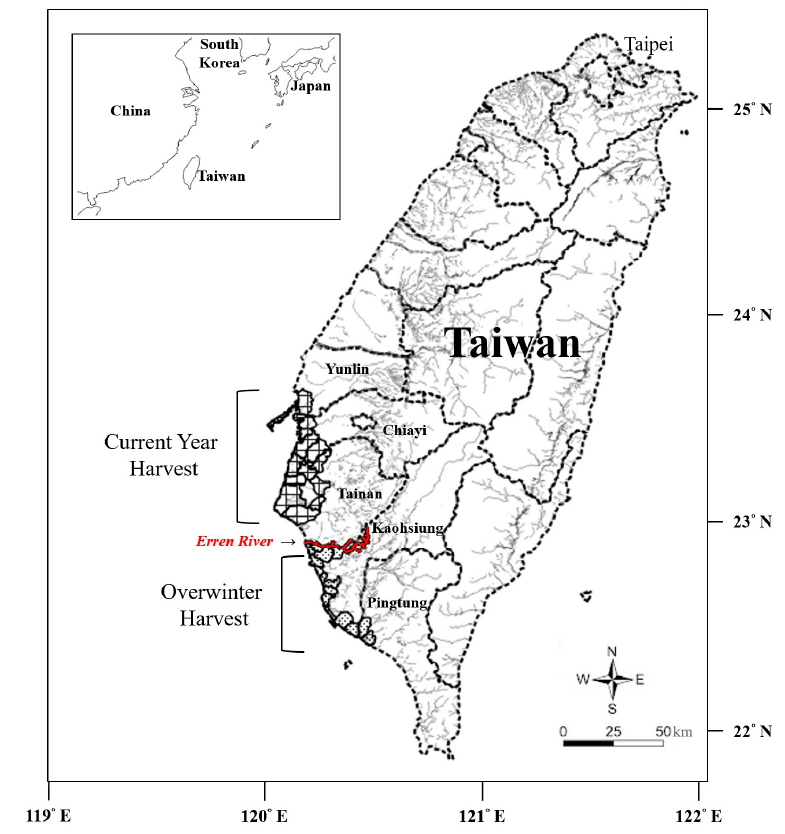
Figure 3. Geographical locations of the milk fish farms in current year harvest and overwinter harvest, Taiwan.